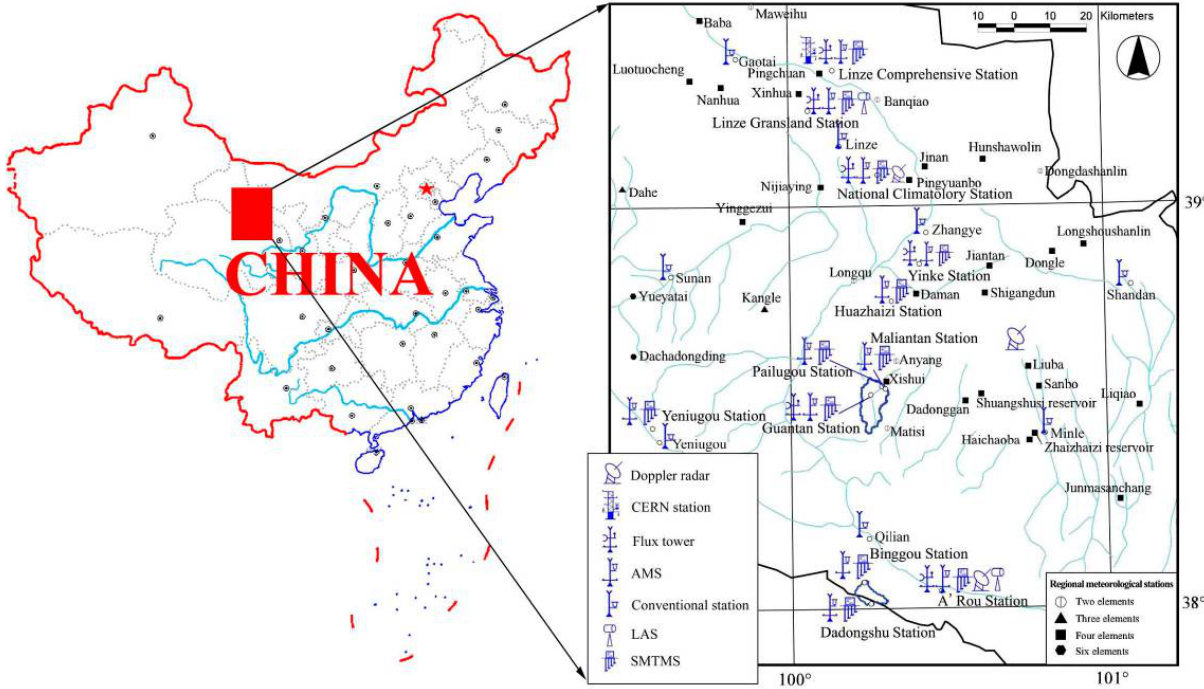
Fig. 1 Map of studying area and observation sites during the WATER Fig. 1. Map of studying area and observation sites during the WATER.